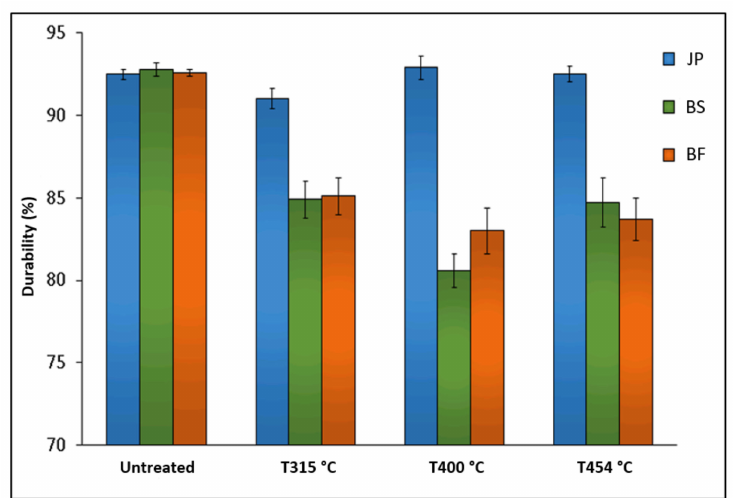
Figure 8. Durability values of untreated- and treated-wood pellets derived from the three species: JP, BS, and